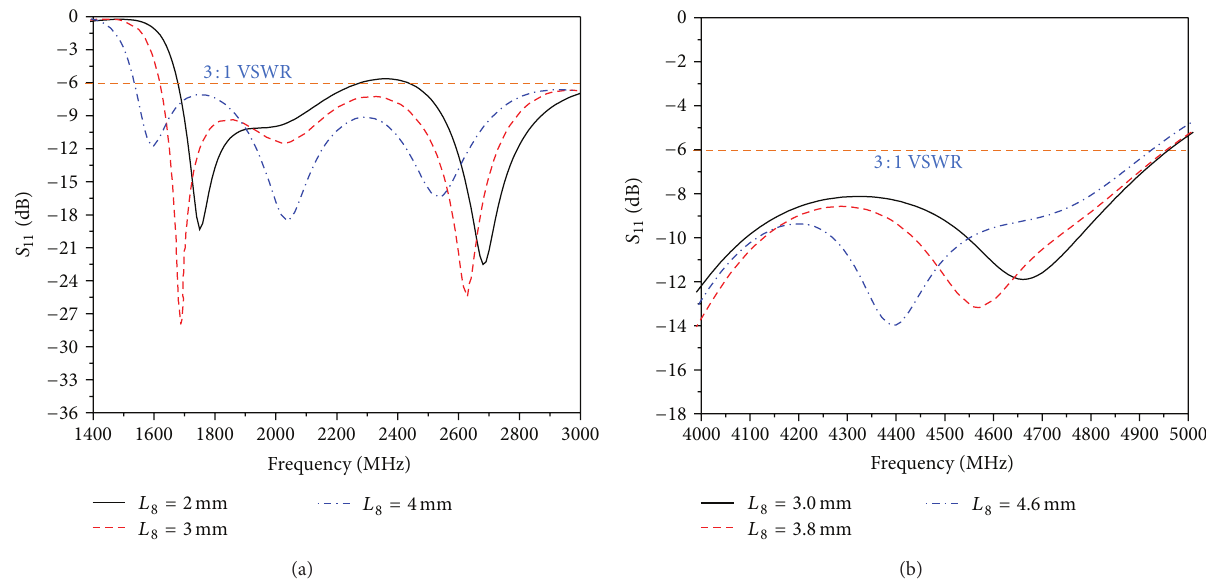
Figure 4: S parameter as a function of (a) 𝐿 8 (1400–3000 MHz) and (b) 𝐿 8 (4000–5000 MHz).